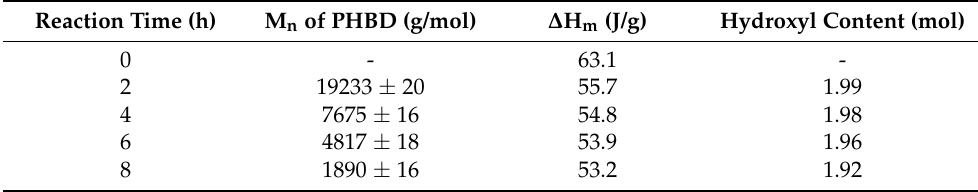
Table 1. Molecular weight of PHBDs at different reaction